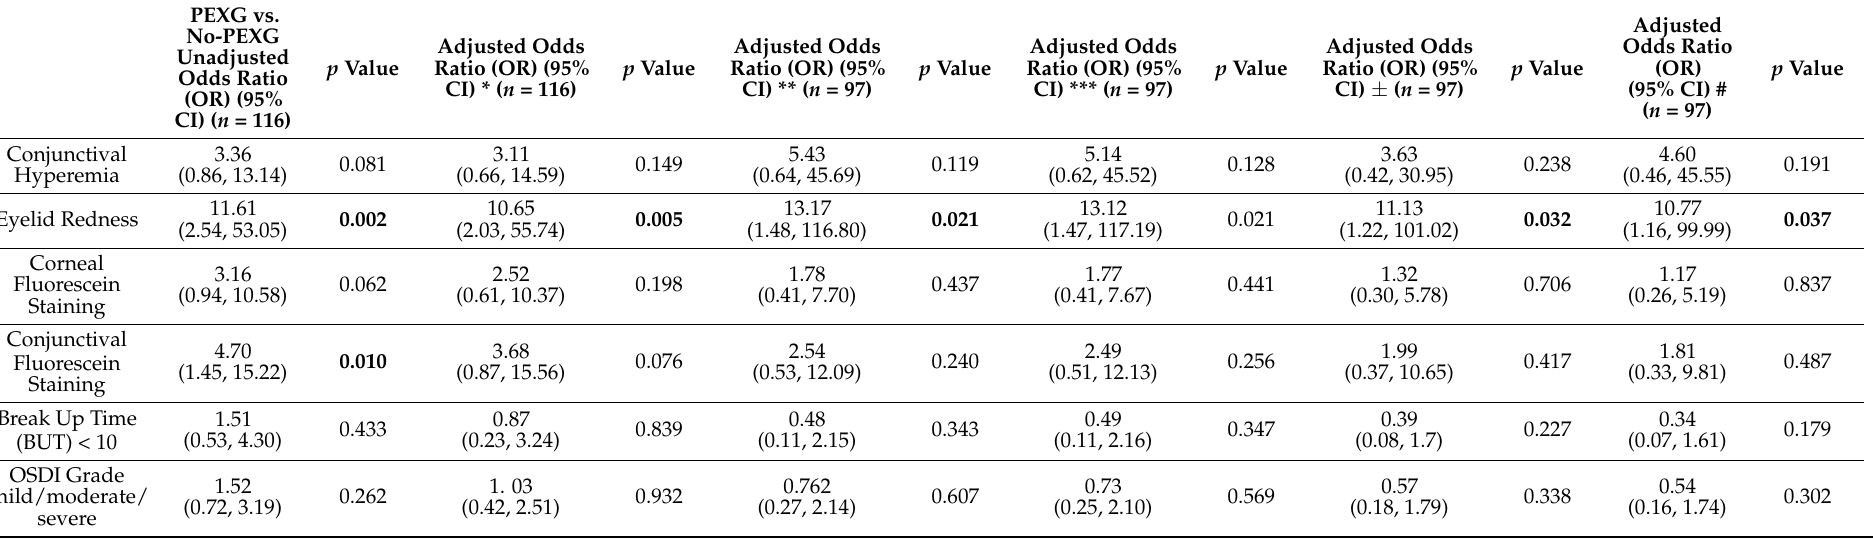
* Adjusted for age, gender and number of drops. ** Adjusted for age, gender, number of drops and CCT. *** Adjusted for age, gender, number of drops, CCT and glaucoma duration. ± Adjusted for age, gender, number of preserved drops, CCT, glaucoma duration and MD (mean deviation). # Adjusted for age, gender, total number of drops, number of preserved drops, CCT, glaucoma duration and MD. Bold stands for statistical